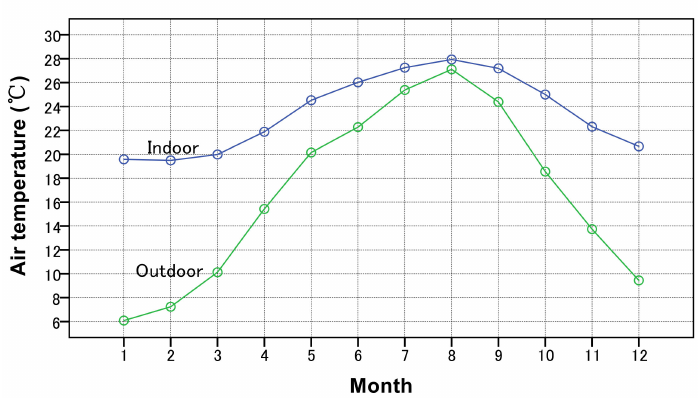
Figure 3. Monthly mean indoor and outdoor air